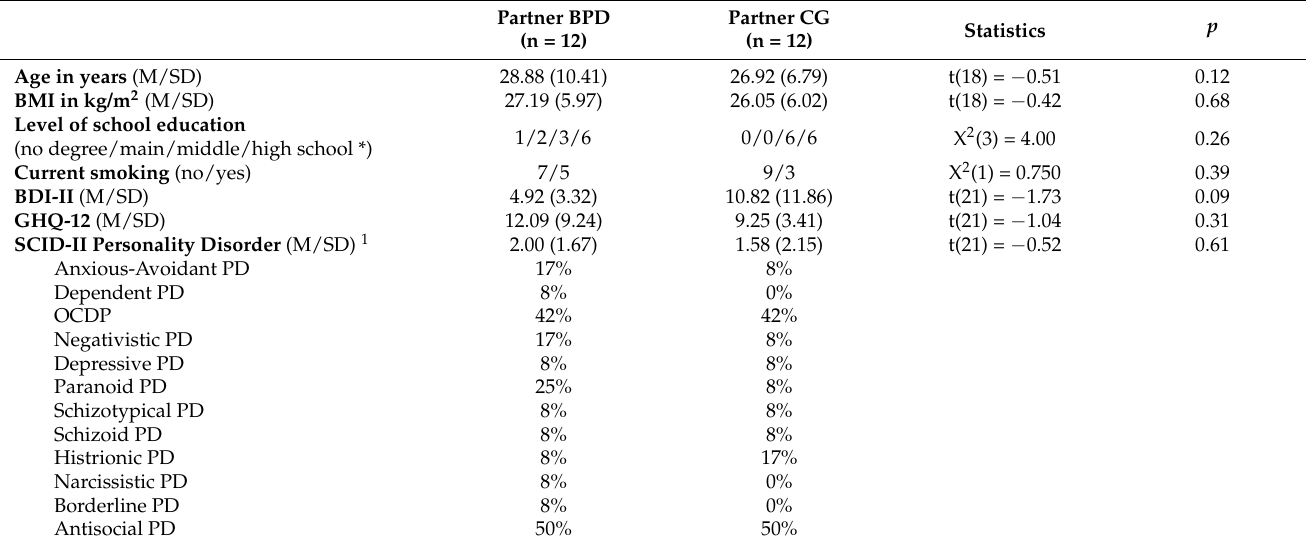
Table 2. Sample characteristics for male